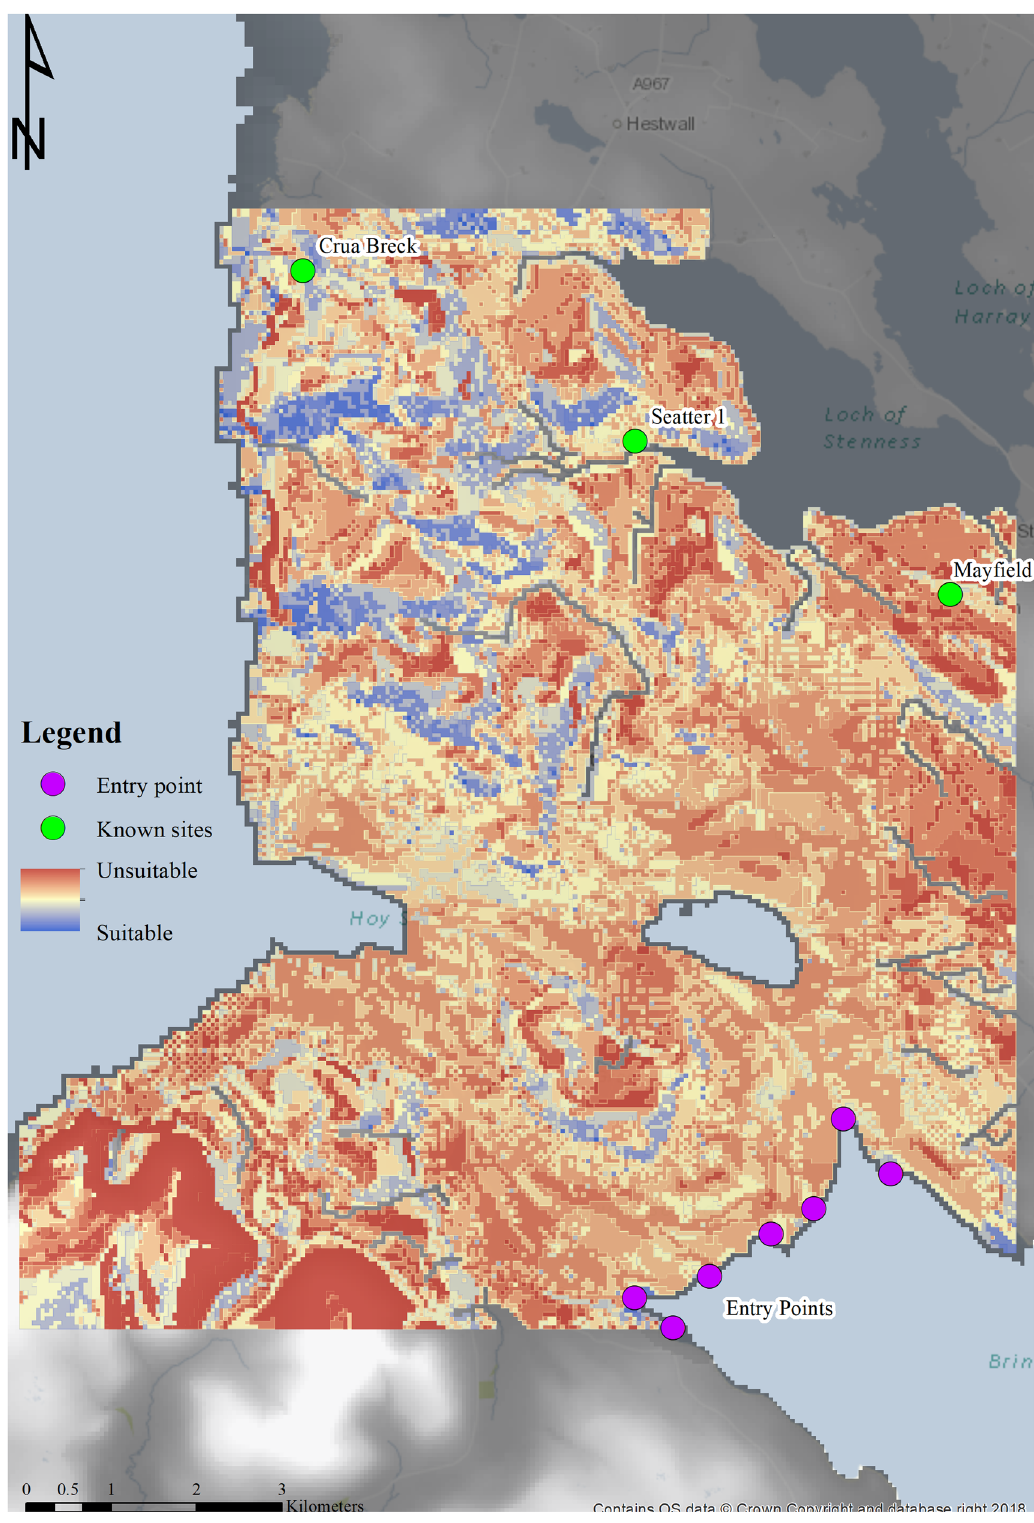
Figure 4: Site suitability prediction map, depicting known sites and the modelled entry